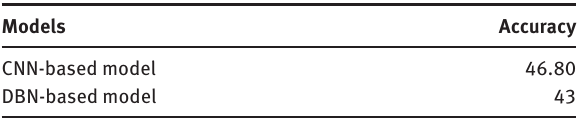
Table 2: Comparisons of Our Proposed Sentiment Analysis